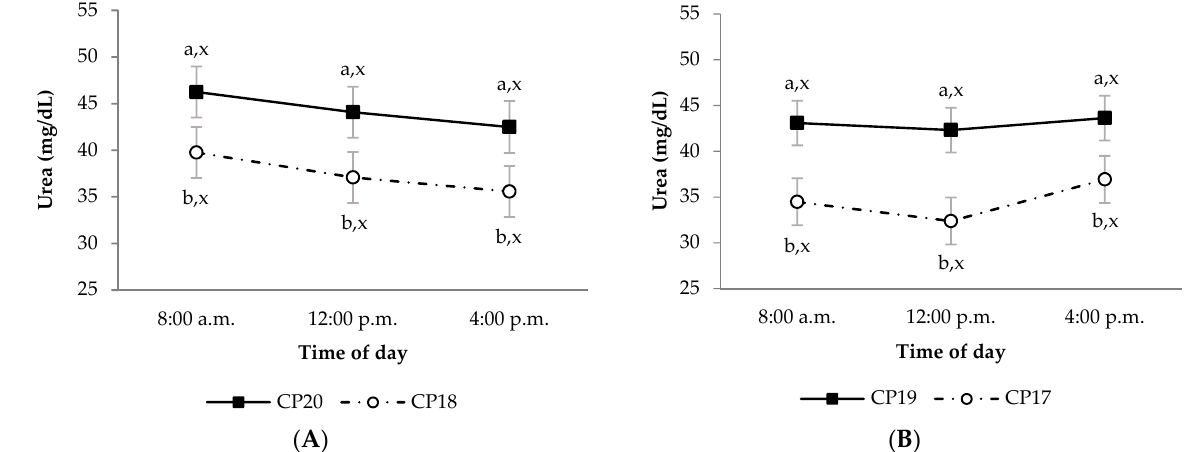
Figure 4. Plasma urea concentrations (mg/dL) in growing ( A ) and finishing ( B ) periods in Ripollesa lambs fed with different concentrations of crude protein were compared between treatments (CP20 vs. CP18 and CP19 vs. CP17) and time of day (least square mean values ± standard error). Within each sampling hour, different letters (a, b) denote statistical differences ( p ≤ 0.05) between dietary treatments. Within each dietary treatment, different letters (x, y) denote statistical differences ( p ≤ 0.05) between sampling hours.